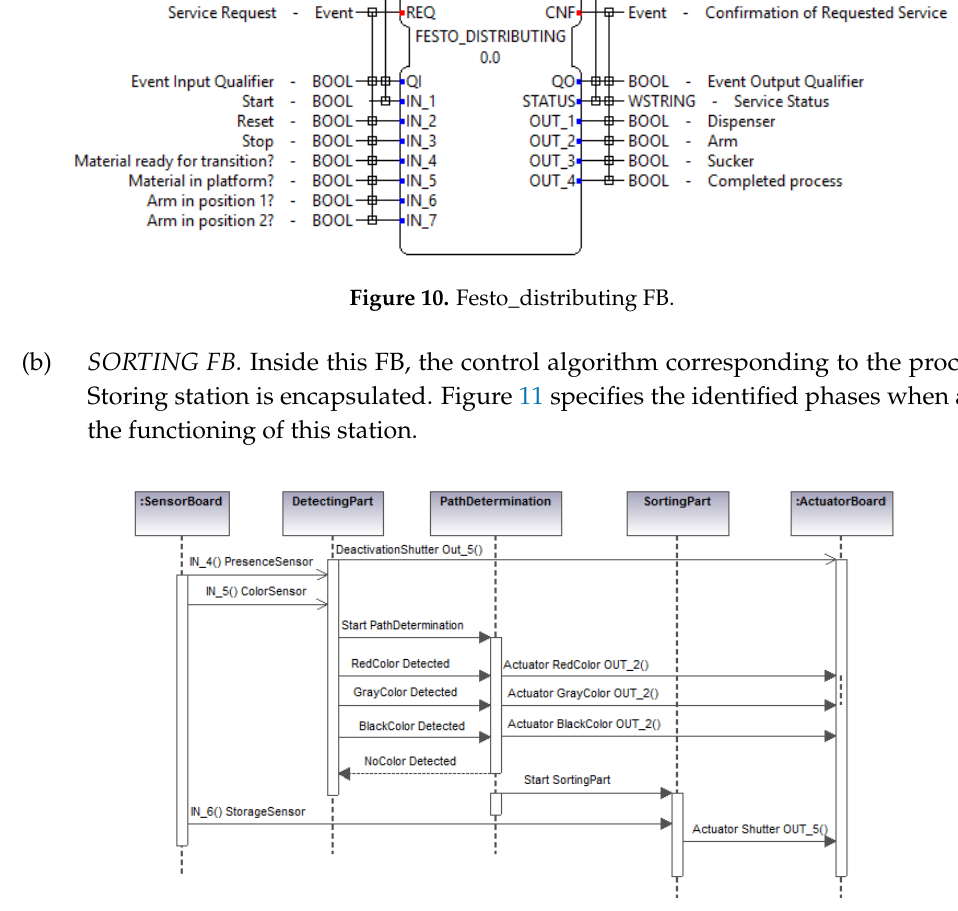
Figure 11. Sorting sequence diagram.